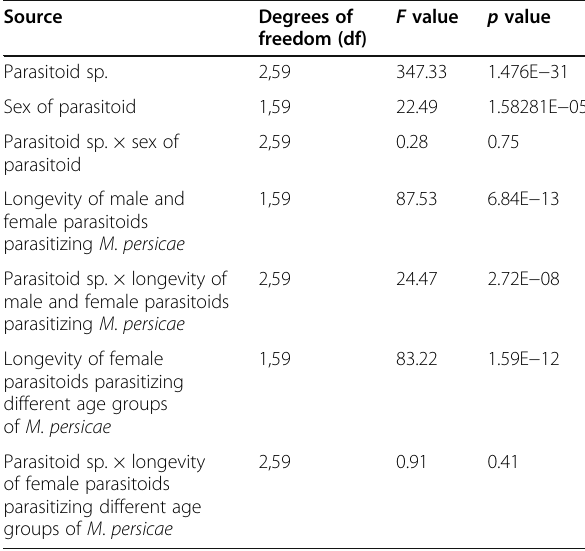
Table 6 ANOVA results for A . asychis , A . ervi , and D . rapae comparing forewing width, mean longevity of male and female parasitoids, and mean longevity of female parasitoids parasitizing different age groups of M .